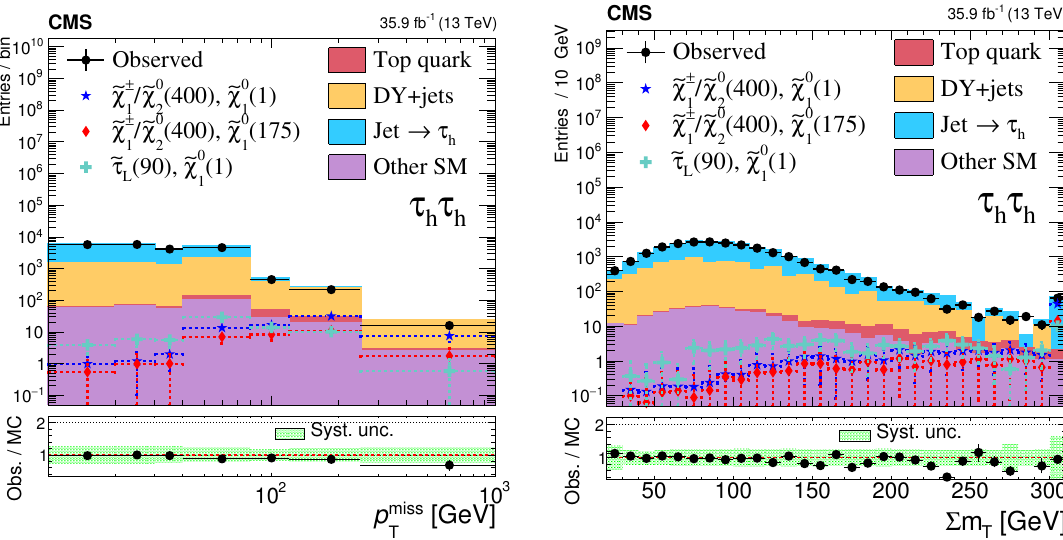
Figure 4. Distributions of the search variables p miss for events after the baseline selection. The black points show the data. The background estimates are represented with stacked histograms. Distributions for two benchmark models of chargino- neutralino production, and one of direct left-handed within parentheses in the legend correspond to the masses of the parent SUSY particle and the